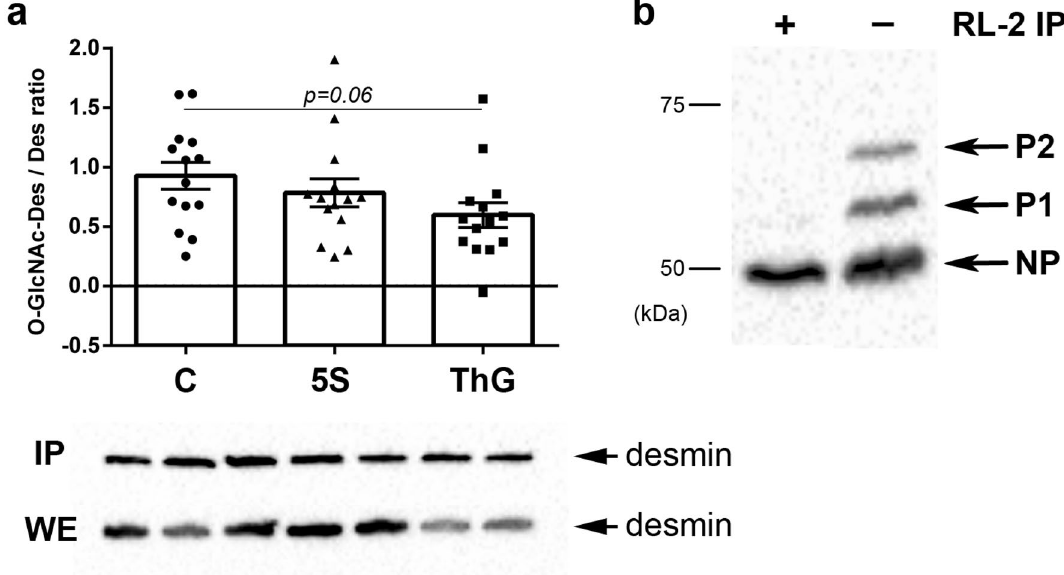
Figure 5. Quantification of desmin O-GlcNAcylation and its interplay with phosphorylation. Changes of desmin O-GlcNAcylation level were determined in whole extract by western blot analysis performed after immunoprecipitation of O-GlcNAcylated proteins from untreated myotubes (C, ● ), and Ac 4 -5S-GlcNAc- and Thiamet G-treated myotubes (5S, ▲ and ThG, ■ respectively). ( a ) Signals were quantified and expressed as ratio of glycosylated protein/protein level (mean ± SEM), and compared to the control condition. The representative signals for whole extract (WE) and the immunoprecipitated proteins (IP) were shown under the histogram. ( b ) Desmin was detected using western blot following Phos-tag-PAGE after immunoprecipitation of O-GlcNAcylated proteins (left lane) comparing with the whole protein extract from untreated C2C12 myotubes (right lane). NP corresponded to the non-phosphorylated desmin, and P1 and P2 the phosphorylated forms of desmin. The tendency of difference comparing with control is indicated on histogram (n = 15; N = 3 independent cultures). Uncropped images of blots are presented in Supplemental